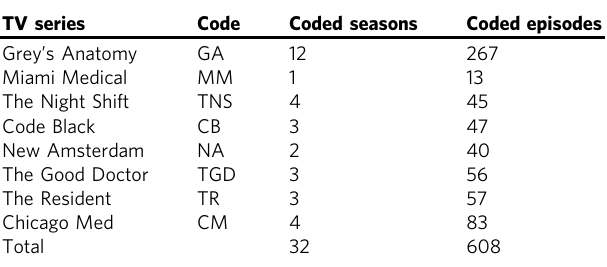
Table 1 Corpus of investigation: we highlight the name and the code of the TV series and the number of coded seasons and